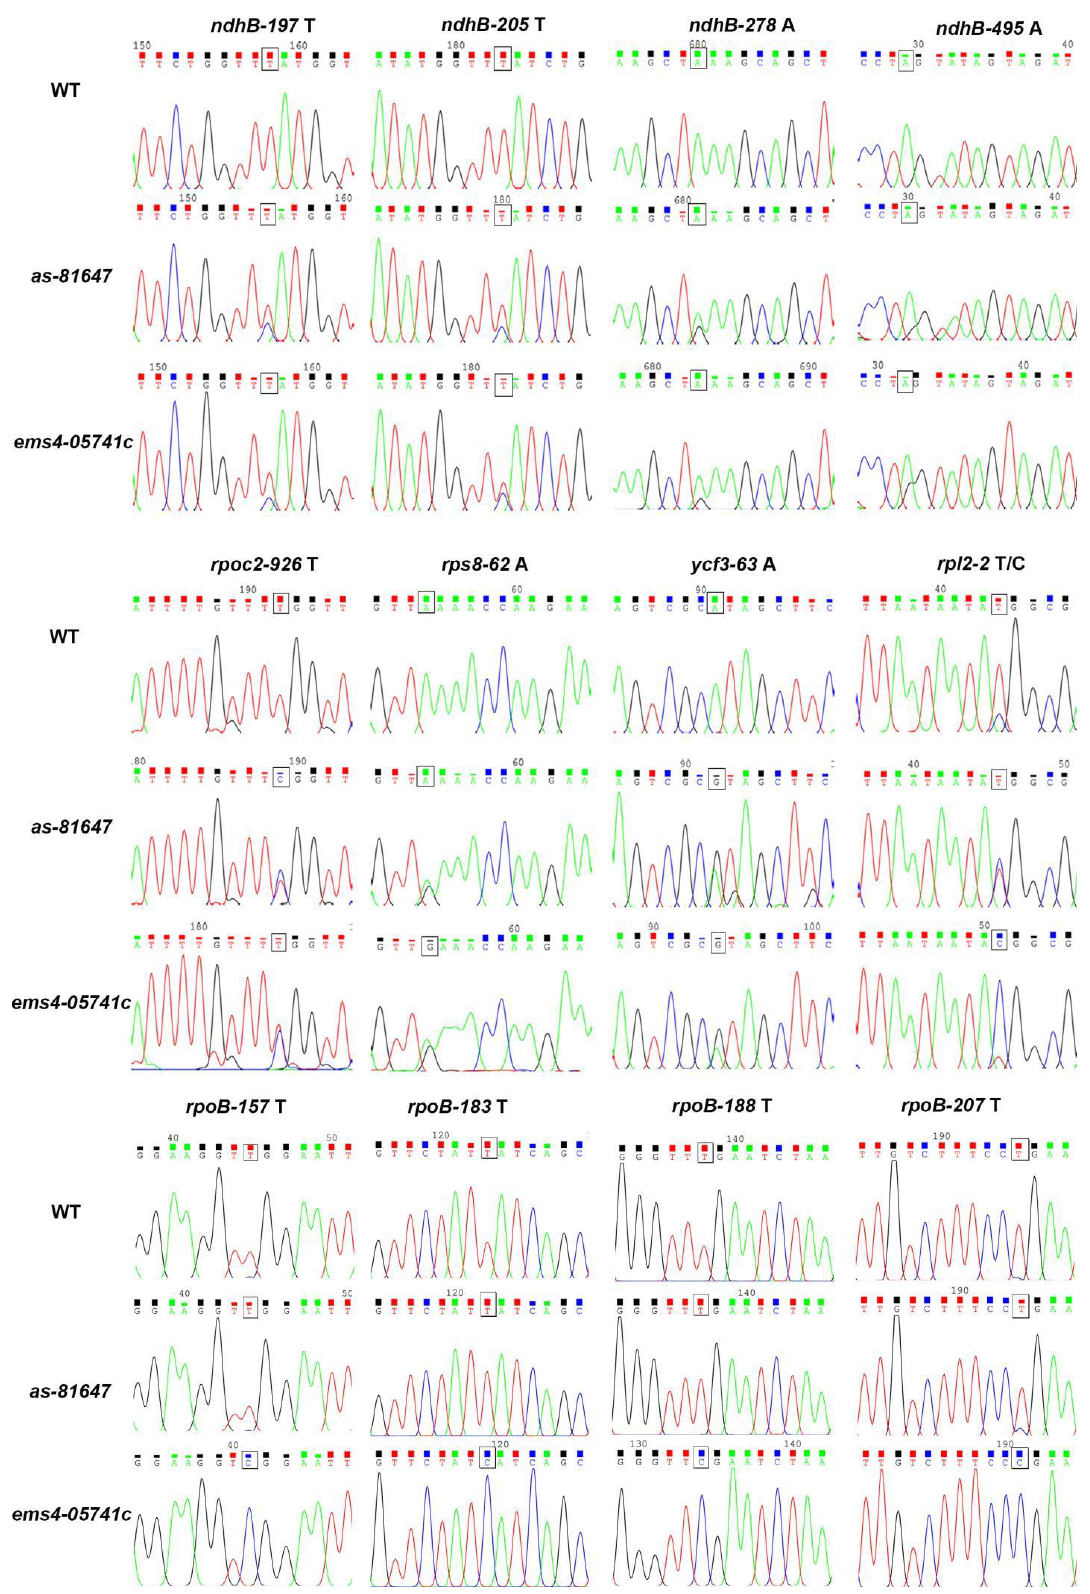
Figure 7. RNA editing analysis of chloroplast transcripts. The editing efficiency of multiple chloroplast transcripts was severely affected in as-81647 and ems4-05741c plants. The box marks the editing site. T (A) stands for edited, C (G) stands for not edited, and T/C stands part edited in